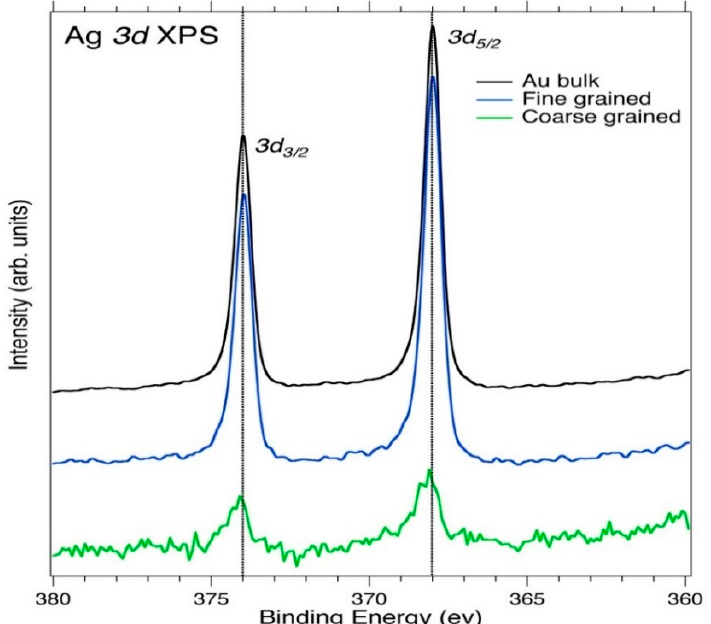
Figure 6. Ag 3d 5/2,3/2 core level XPS spectra of the bulk Au and powder (unprocessed and processed) Au samples. The dashed line connects the peaks as well as the apparent spin-orbit-splitting maxima. The Ag 3d 5/2,3/2 spectra in Figure 6 show well-separated spin-orbit components ( Δ metal = 6.0 eV); the peaks display asymmetric peak shapes for the Ag metal and also show loss features in the higher BE side of each spin-orbit component of the Ag metal [63]. The bulk Au and fine-grained Au powder concentrate, show higher intense peaks due to the high number of Ag atoms present in the samples, interacting with unfilled electron levels of the valence band above E F . The lower intense peaks and the loss of features for the coarse-